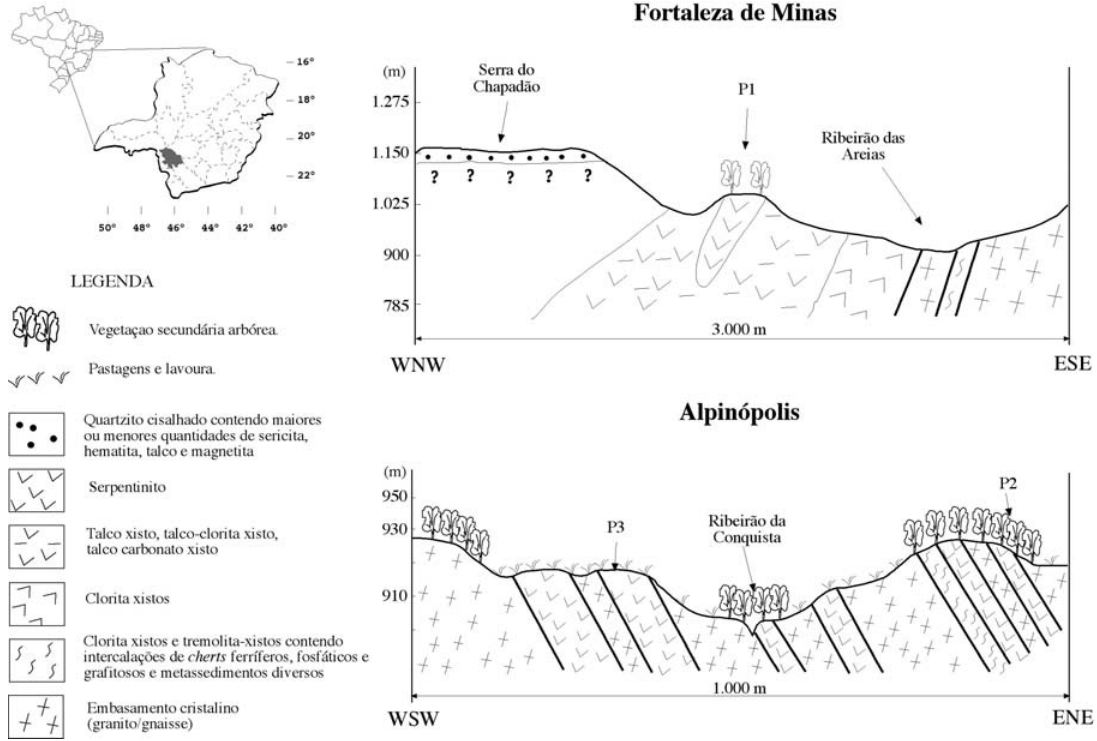
Figura 1. Localização da área de estudo e representação esquemática do relevo, litologia e situação dos perfis